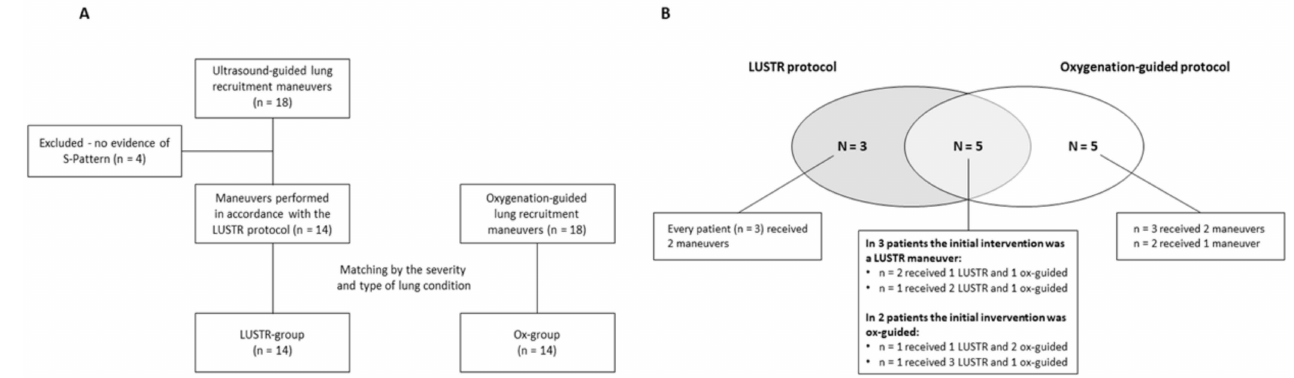
Figure 2. ( A ) Flow diagram for the study groups. ( B ) Venn diagram describing the distribution of the interventions among the study